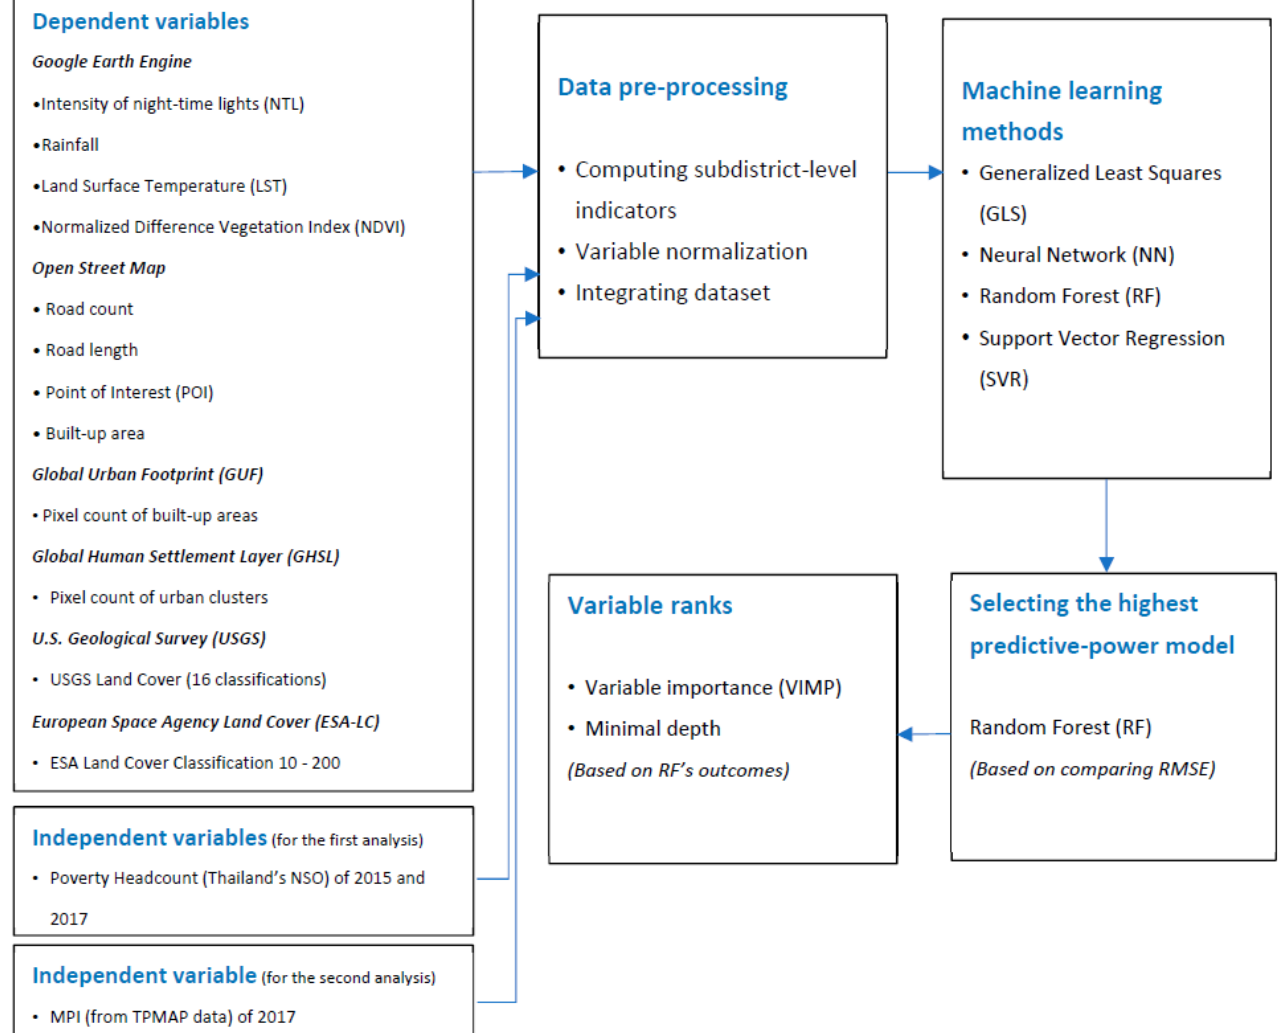
Figure 10. Analytical framework of this study. Source: Graphics generated by authors.